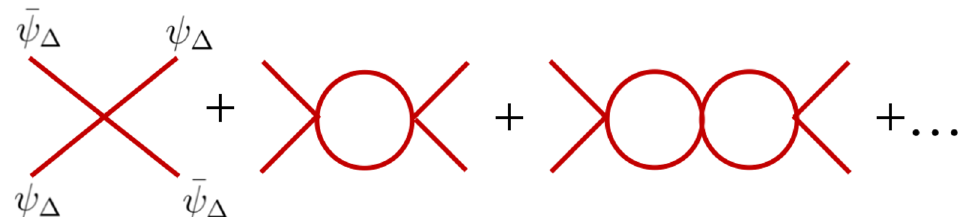
Figure 3 . The Gross-Neveu model on AdS. The 4-point correlator at large- N is given by an infinite sum of bubble diagrams. The red lines are fermionic propagators. The boundary of AdS is not shown in the